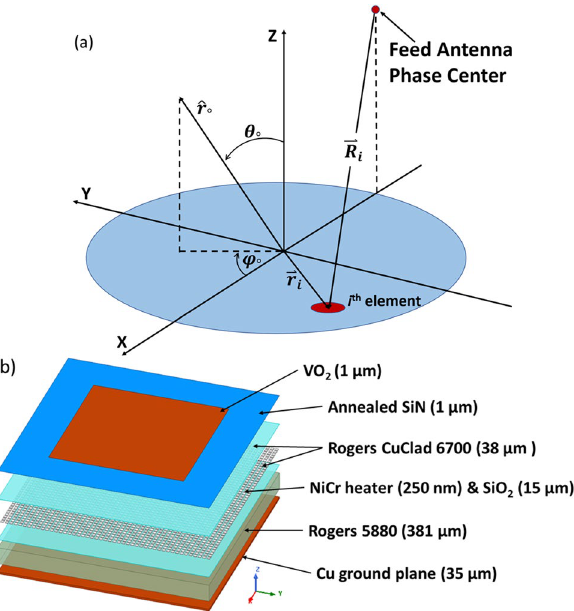
Figure 1. ( a ) Diagram describing differential spatial phase delay of a reflectarray. ( b ) Exploded device structure with